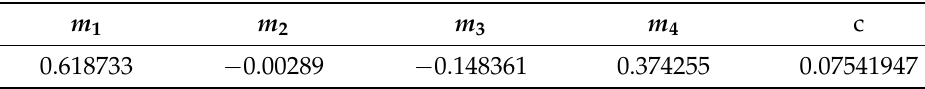
Table 4. MLR: coefficients and intercept